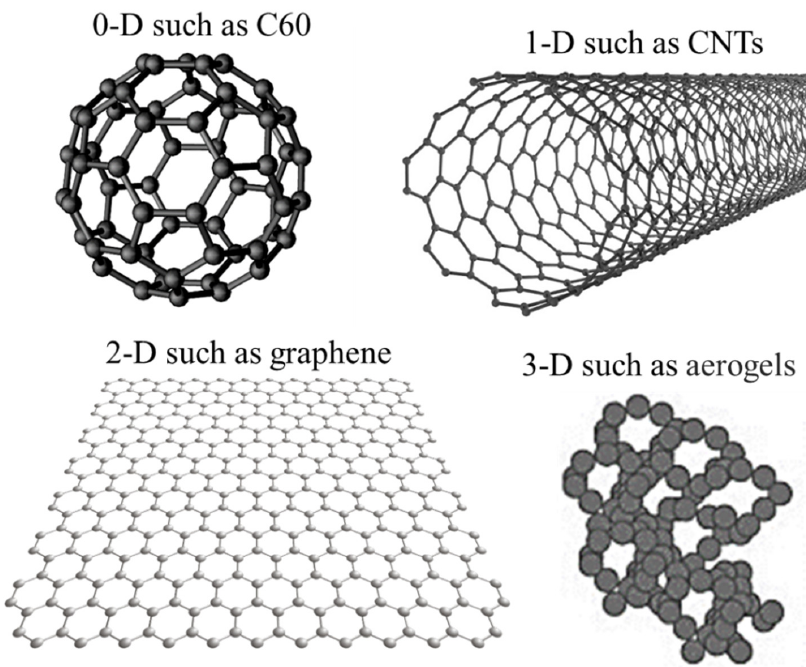
Figure 11. Schematic of 0D (C60 fullerene), 1D (CNT), 2D (graphene), and 3D (nanocarbon aerogels) nanostructures of carbon-based materials [57] .